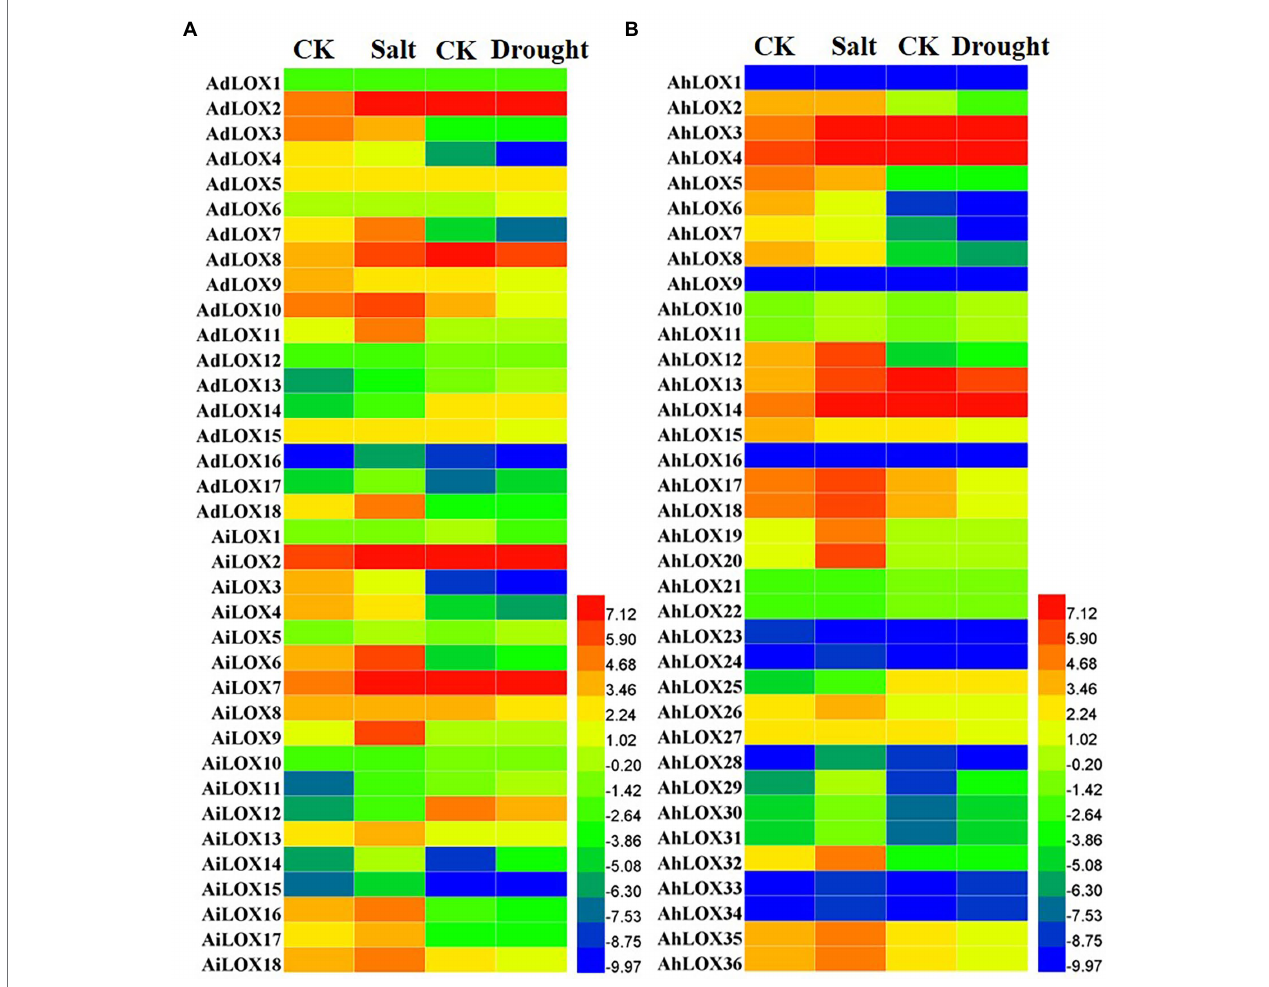
FIGURE 8 | Heatmap of the expression patterns of LOX genes under salt and drought stress treatments in peanut (A and B) . The FPKM values of the peanut LOX genes were log2-transformed to create the heatmap using Heml software. The red and blue colors represent the higher or lower relative abundance of each LOX gene,